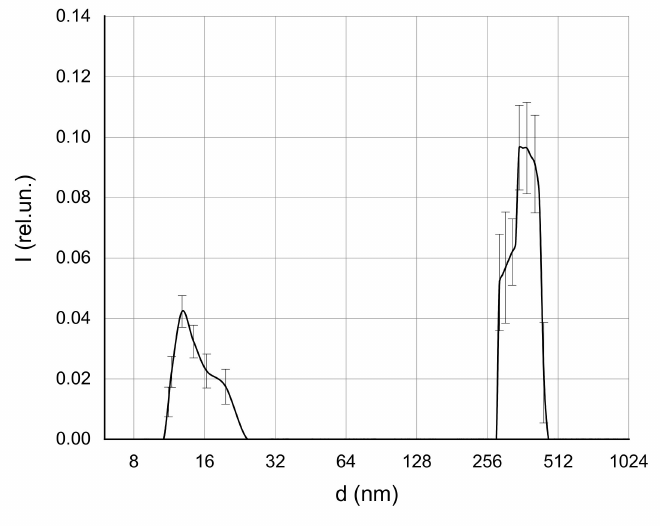
Figure 5. Size distribution of magnetic nanoparticles in MF solution.